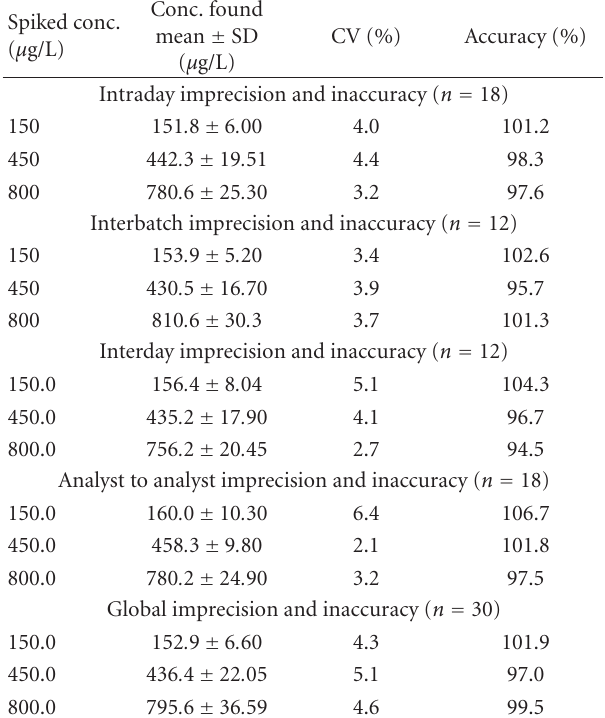
Table 1: Imprecision and inaccuracy results of validation. Spiked conc.